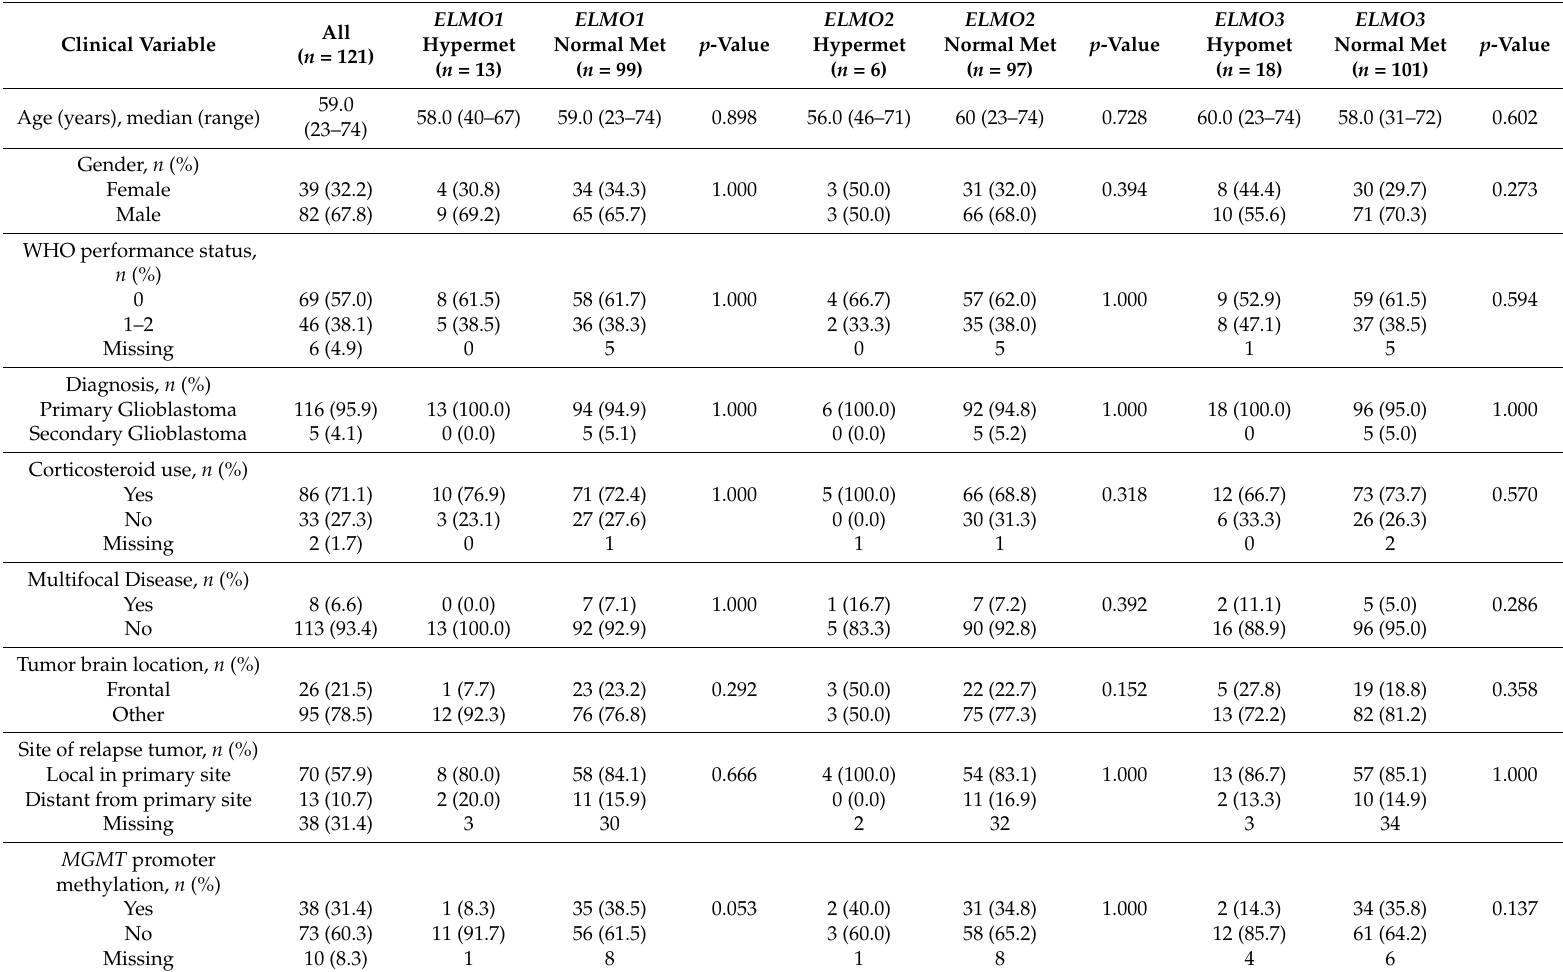
Table 1. DNA Methylation Status of the ELMO Genes According to Patient